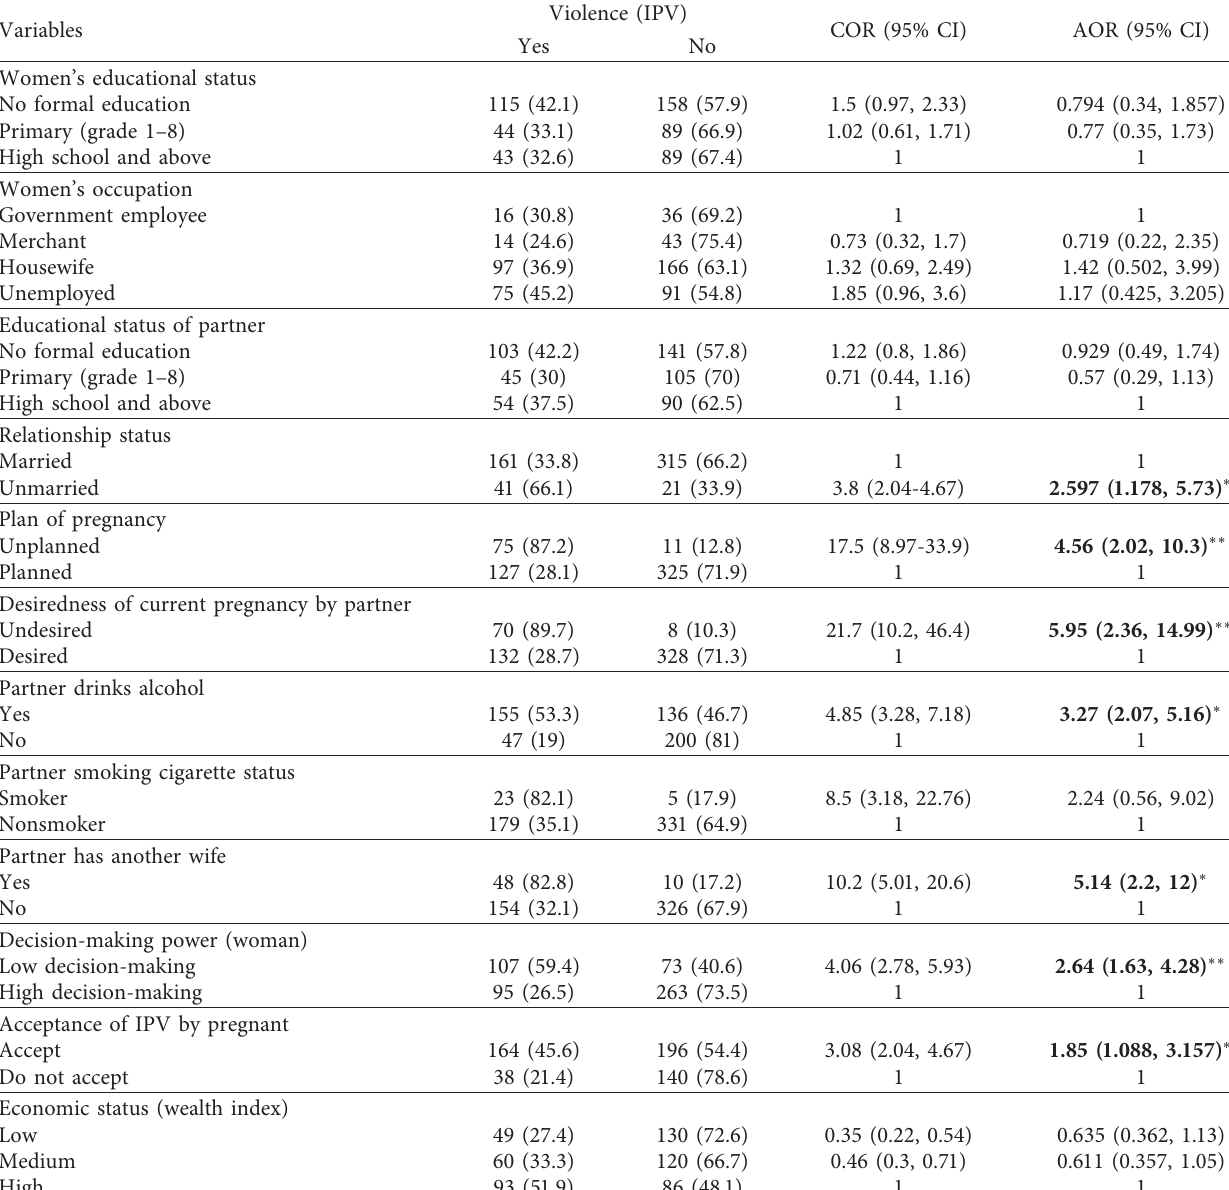
Table 2: Factors independently associated with the experience of intimate partner violence during pregnancy in Ofla District, Tigray, Ethiopia, 2019 ( N �